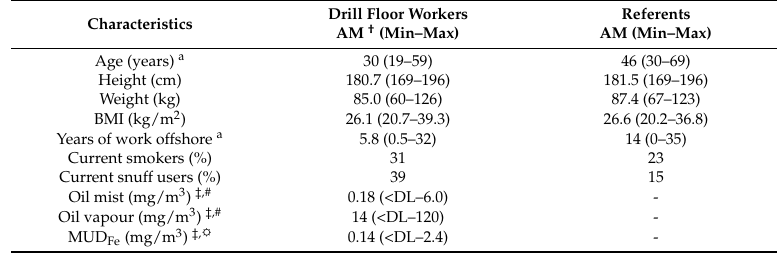
Table 1. Background characteristics of 65 drill floor workers and 65 referents at baseline.